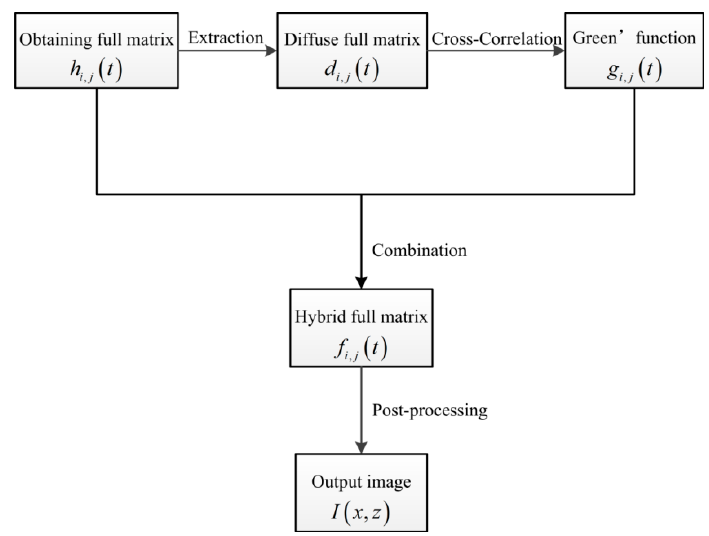
Figure 5. Flow chart of the experimental procedure.